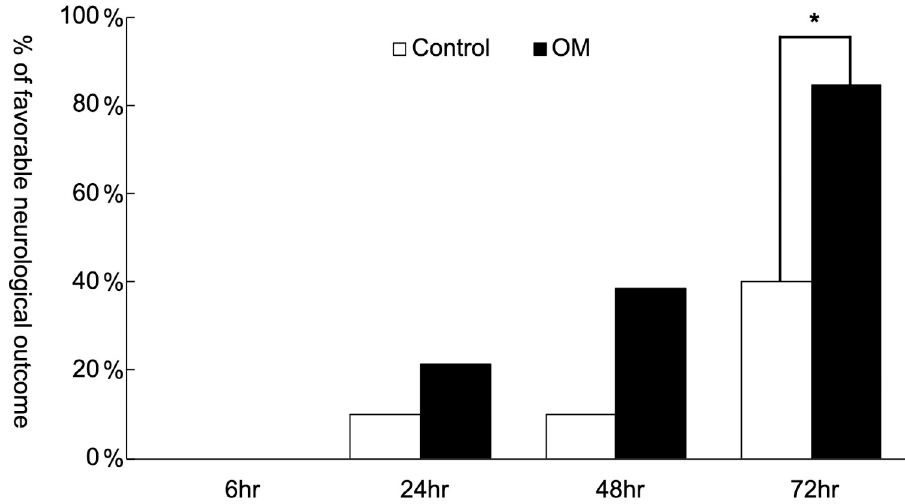
Fig 4. Neurological outcome of control and OM groups at 6, 24, 48 and 72 h after cardiac arrest and resuscitation. ( � : P = 0.026).